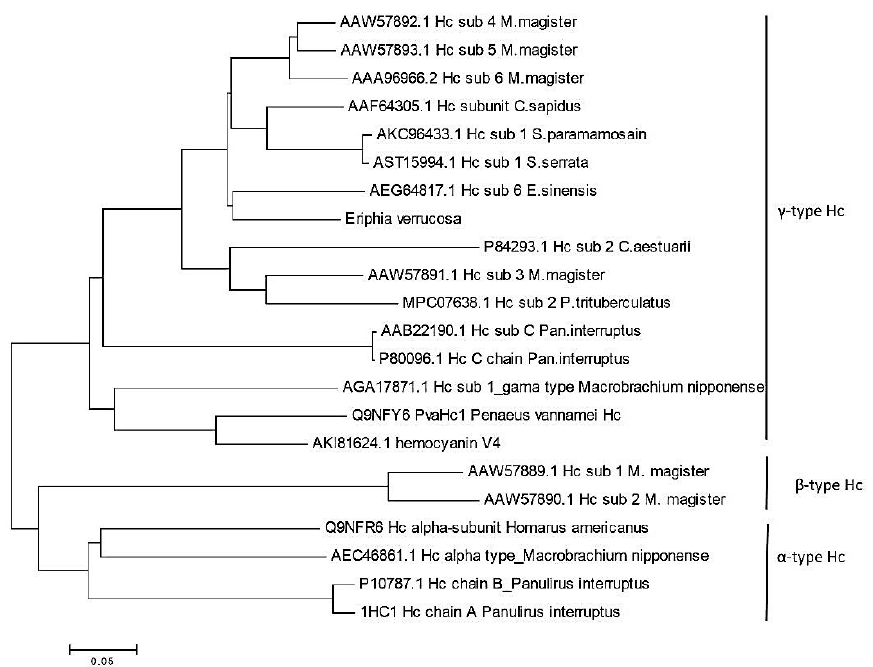
Figure 2. Phylogenetic analysis of E. verrucosa hemocyanin. The tree was constructed by MEGA software version 6.06, using the Bootstrap Neighbour-Joining method. The reliability of each branch was tested by 1000 bootstrap replications. The numbers at the nodes represent bootstrap values. Hemocyanin sequences obtained from NCBI correspond to the following species: Metacar- cinus magister —Dungeness crab (AAW57892.1, AAW57893.1, AAA96966.2, AAW57891.1, AAW57889.1, AAW57890.1); Eriocheir sinensis —mitten crab (AEG64817.1); Calinectes sapidus —blue crab (AAF64305.1); Scylla para- mamosian and Scylla serrata —green mud crab (AKC96433.1, AST15994.1); Carcinus aestuarii